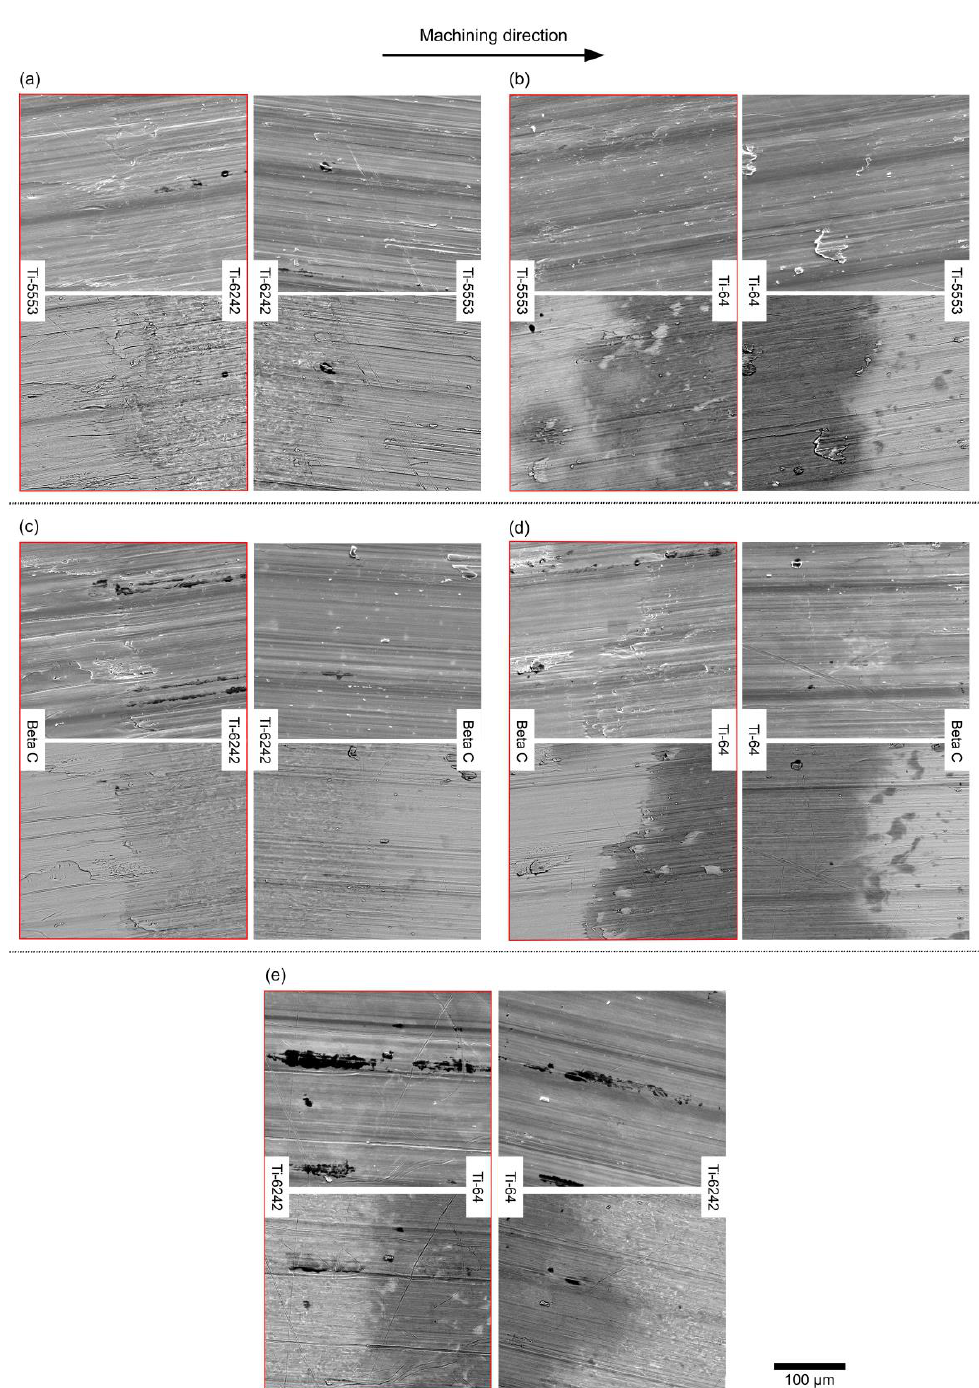
Figure 9. Scanning and backscattered electron micrographs of the diffusion bond pairings showing the machined surface of the bonds. For each alloy pair, the secondary electron micrographs are on the top row and the backscatter electron micrographs are on the bottom row. ( a ) Ti-6242/Ti-5553, ( b ) Ti-64/Ti5553, ( c ) Ti-6242/Beta C, ( d ) Ti-64/Beta C and ( e ) Ti-6242/Ti-64. The damage produced in the bond is not linked to a specific microstructure. The results shown in Figure 9 have also been observed in other samples with bonds produced from the titanium alloys—Beta C and Ti-6242—processed at 1100 ◦ C for 60 min and 25 min. This temperature is above the β transus temperature of both alloys, and thus, the microstructure of Ti-6242 is fully lamellar instead of the equiaxial microstructure presented in this